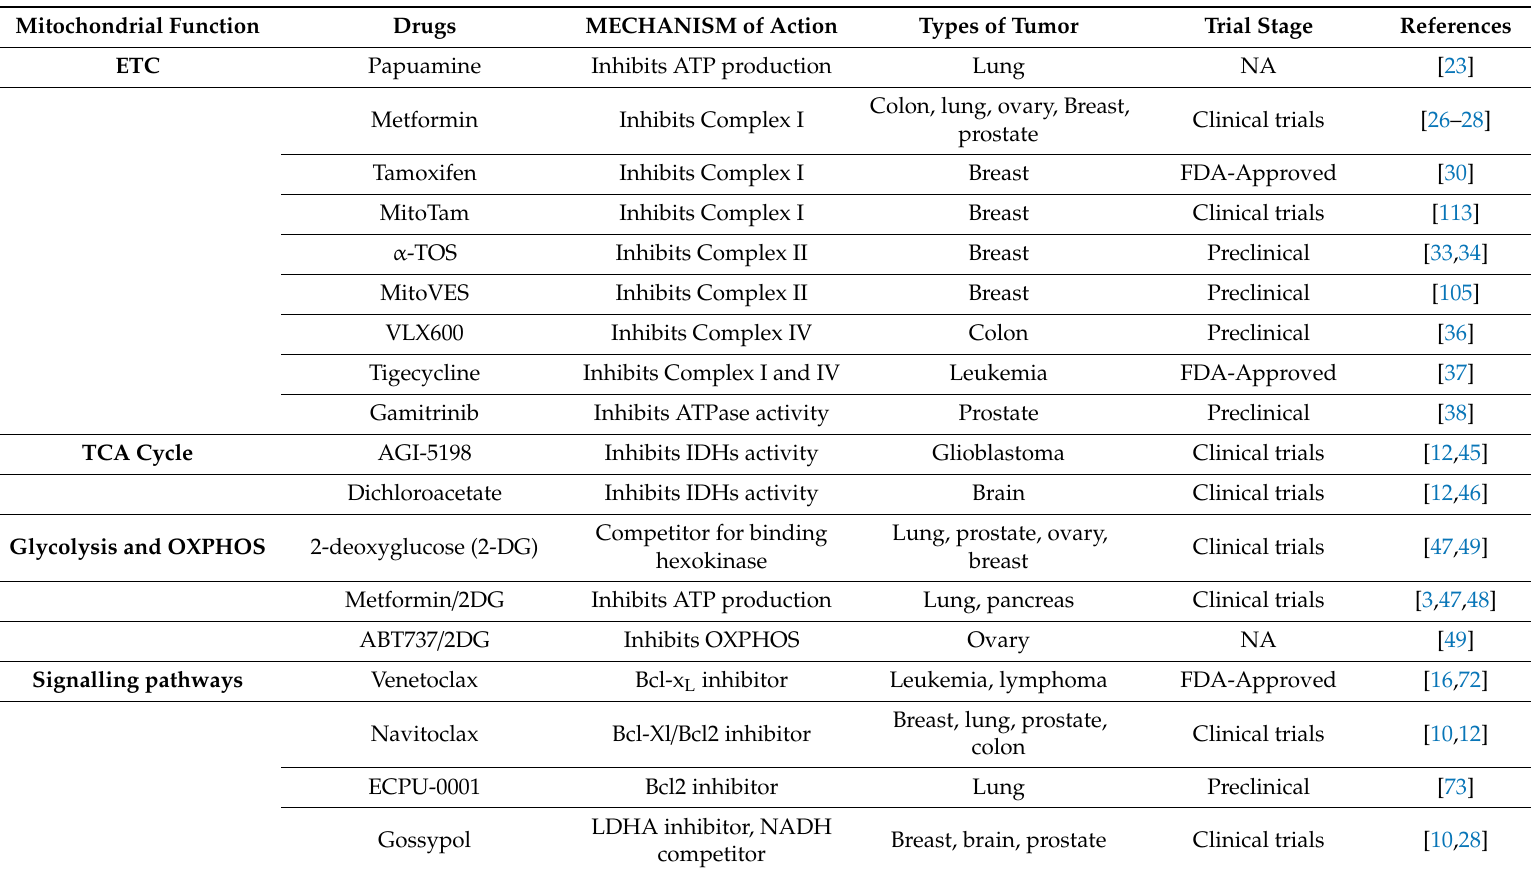
Table 1. A summary of the anti-cancer drugs discussed in this review and their mechanism of